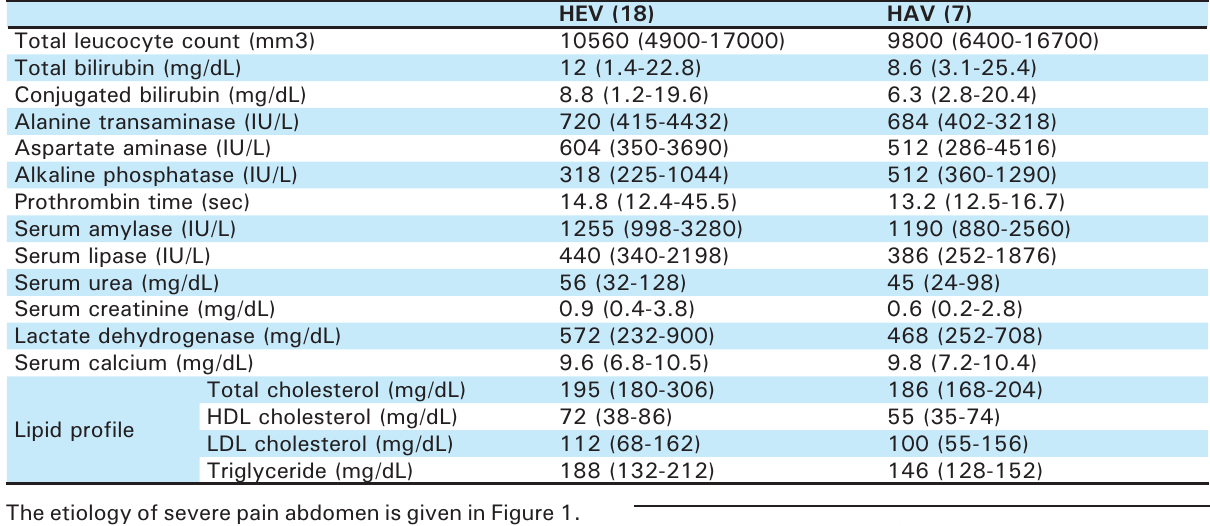
Table 4. Laboratory investigations in patients of acute pancreatitis at